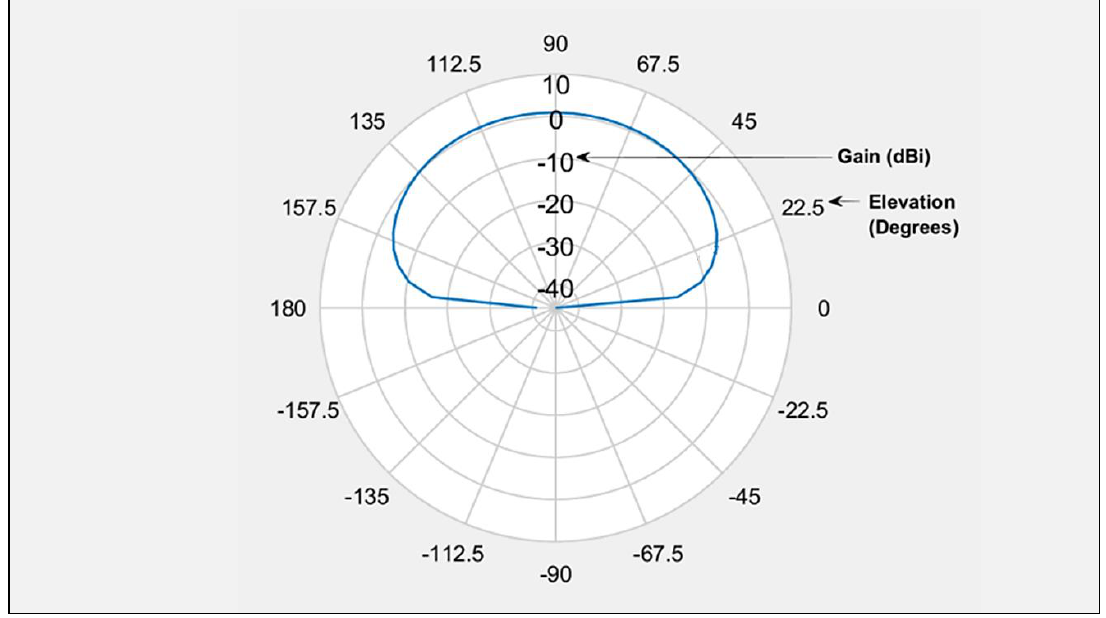
Figure 8. Microstrip patch antenna radiation pattern. Sensors 2019 , 19 , x FOR PEER REVIEW